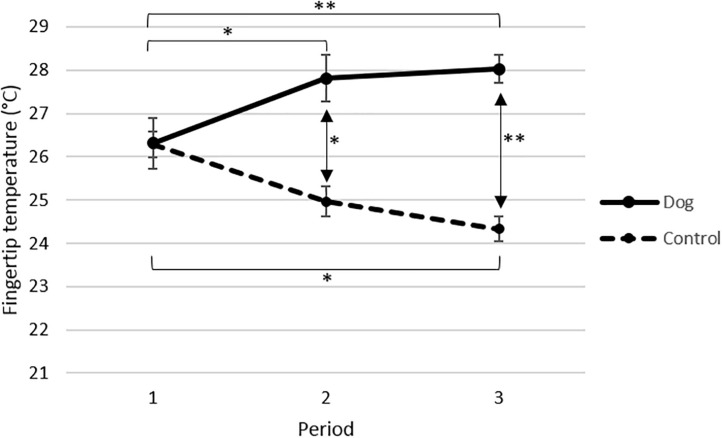
Mean fingertip temperature °C (±SE) for elderly before (period 1) and in connection with interacting with a visiting dog and its handler (periods 2 and 3) in the dog group (n = 13), and for elderly not interacting with a visiting dog during the corresponding time points in the control group (P1 n = 15, P2 n = 13, P3 n = 11). All data are based on mean values from sampling times 0 and 20 min. Data from each period are based on four separate visits. p-Values are adjusted from Tukeys post hoc test. ∗∗p < 0.01, ∗p < 0.05.